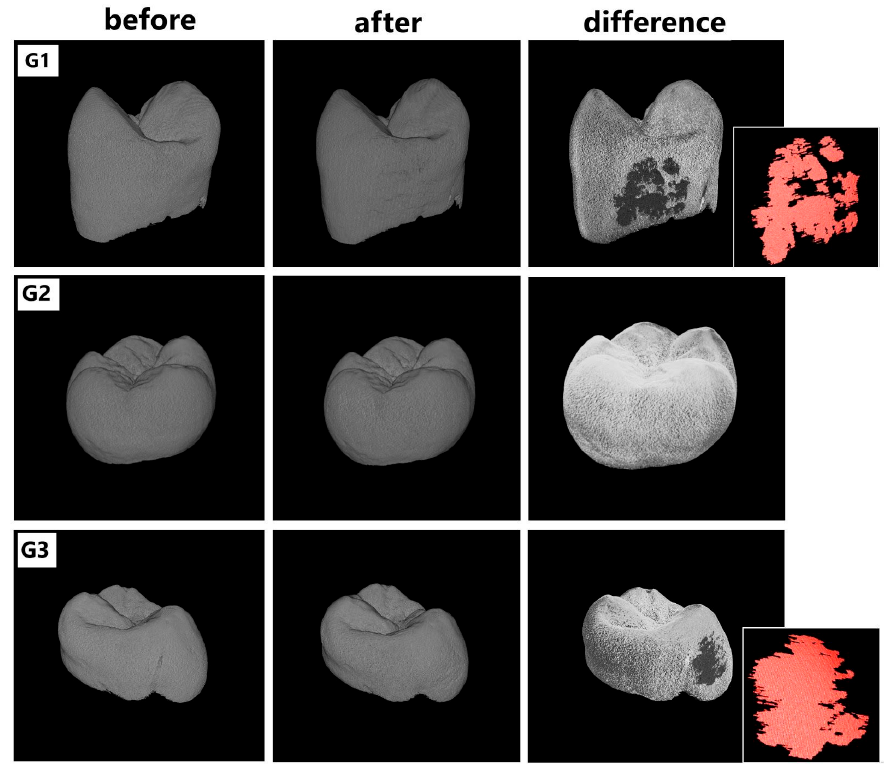
Figure 4. Comparison of pictures depicting the surface of example teeth of G1–G3 groups, condi- tioned with different techniques, taken using X-ray microtomography—1172 SkyScan, Bruker. The pictures depicting differences were obtained by subtractive operation using the DataViewer software (SkyScan 1172, Bruker, Kontich, Belgium) .